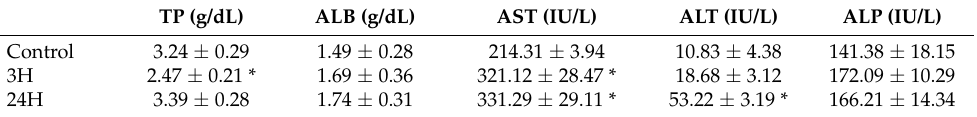
Table 1. Blood chemistry data for both treated and untreated mice at various timepoints.